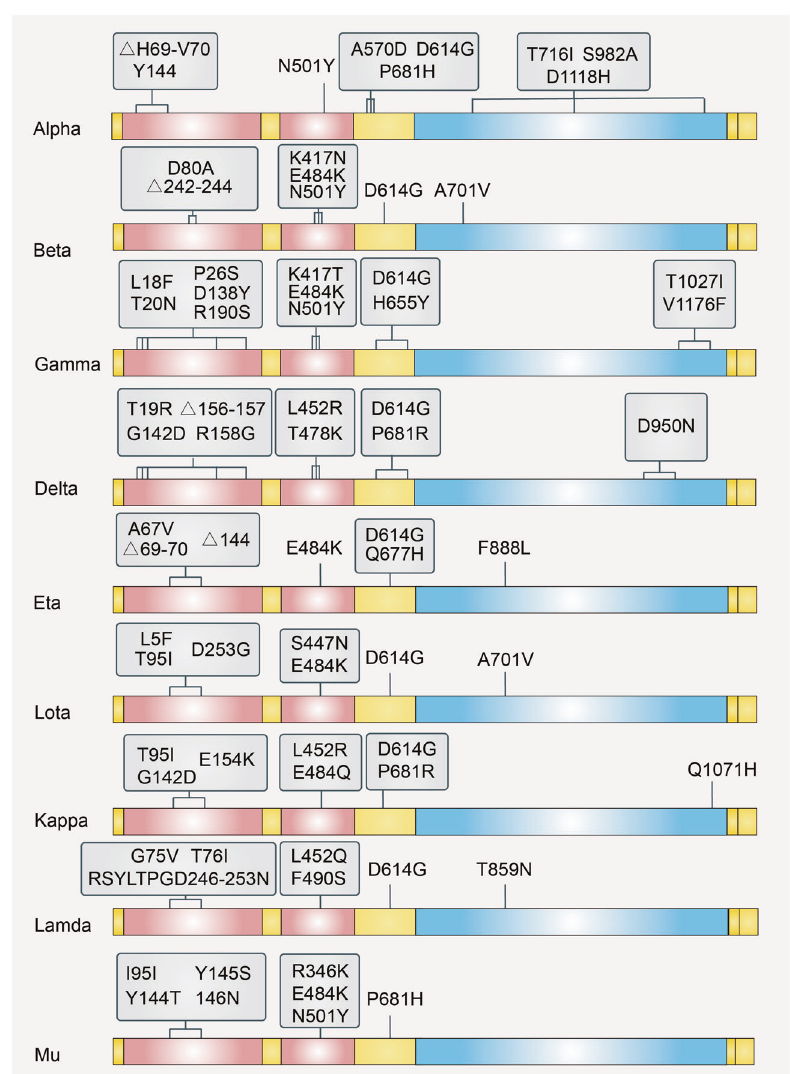
Fig. 2 Illustration of common mutations in the S protein sequence of different SARS-CoV-2 variants of concern and